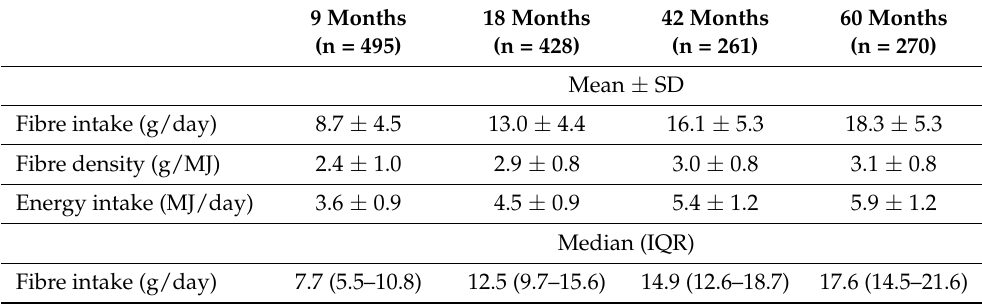
Table 2. Fibre intakes (grams per day), fibre density (grams per MJ), energy intake (MJ per day)